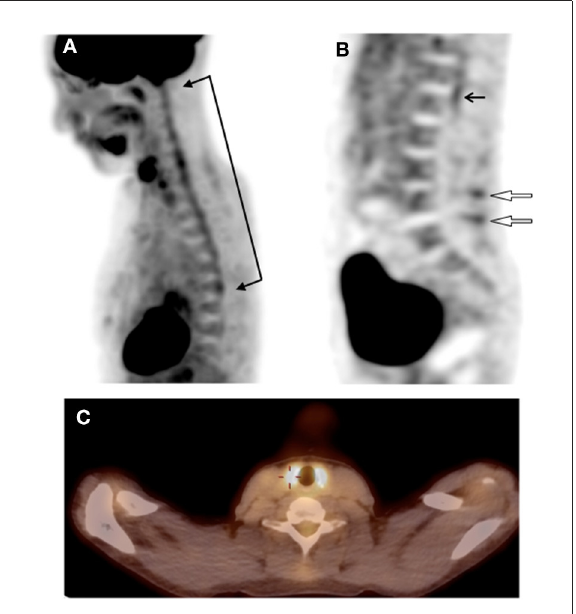
FIGURE2 (A) sagittal view of FDG-PET/CT showing hypermetabolism of the spinal cord at the cervicothoracic level (between arrows). (B) sagittal view of FDG-PET/CT showing hypermetabolism of the spinal cord at the lumbosacral level (black arrow) and an interspinous hypermetabolism at two level of the lumbar spine (open arrows). (C) fused FDG-PET/CT image on the transverse plane showing a marked and diffuse hypermetabolism of the thyroid gland. FDG-PET/CT, whole body 19-fluorodeoxyglucose positron emission tomography with computed